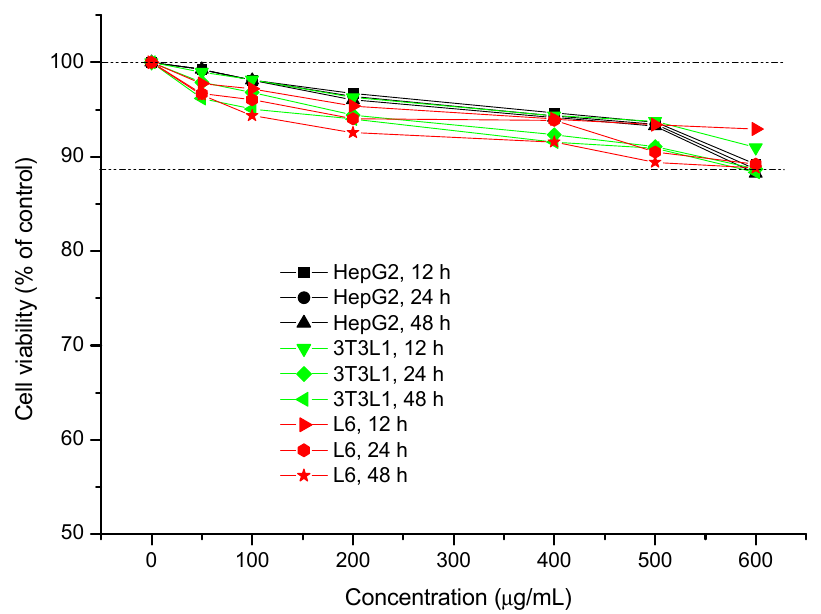
Figure 6. The influences of polysaccharide H-1-2 on the cellular viability of HepG2, 3T3L1, and L6 cell lines, at different concentrations and different times.